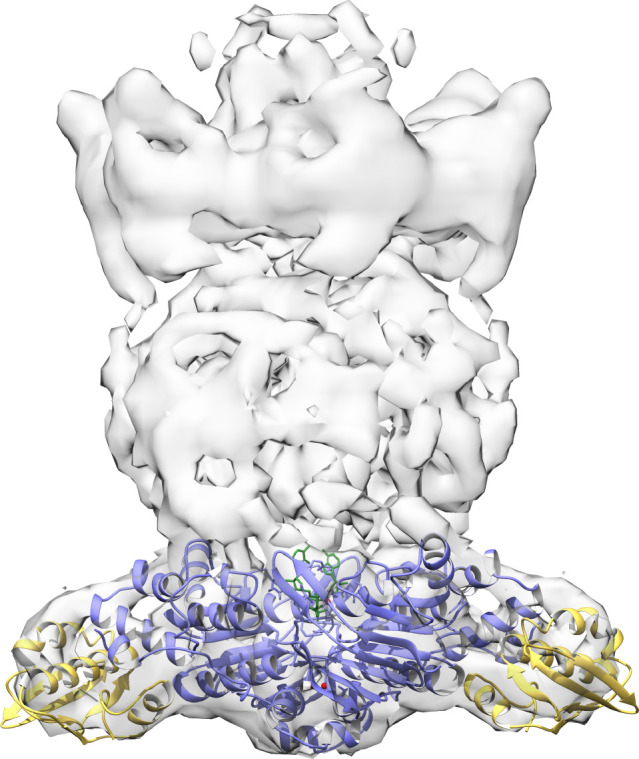
Docking of ADP-bound MlaF2B2 complex into previous low resolution EM density map of E. coli MlaFEDB (EMD-8610).